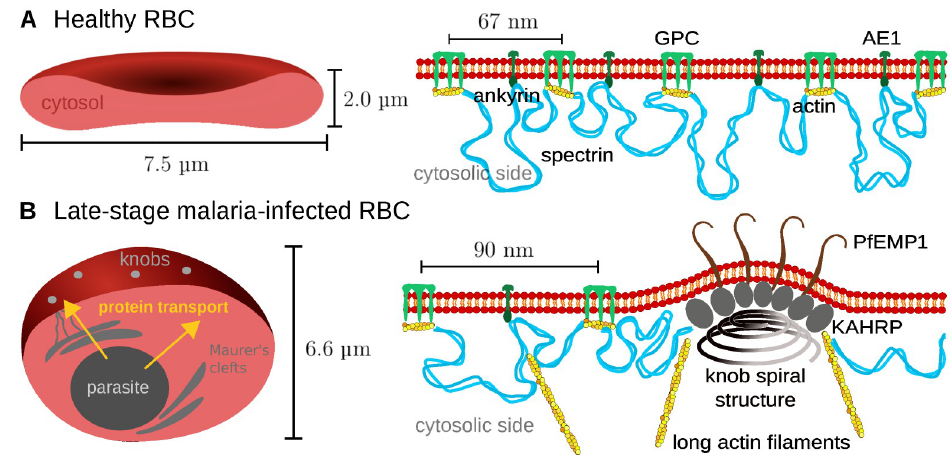
Fig 1. The membrane skeleton in healthy and infected red blood cells. (A) Left: schematic representation of a cut through a healthy RBC with a biconcave shape. Right: closeup of the coupling between the actin-spectrin network and the lipid bilayer. The actin protofilaments of the junctional complexes bind to glycophorin C (GPC) and ankyrin binds to anion exchanger 1 (AE1, also known as band 3). (B) Left: schematic representation of the late stage of the malaria infection, when the RBC has changed to a spherical shape and adhesive knobs have formed on its surface. Right: closeup of the internal structure of the knobs, with a spiral structure at the base, the PfEMP1 adhesion receptors in the membrane at the top and KAHRP-molecules inbetween. Actin is mined from the junctional complexes and forms long filaments often connected to the Maurer’s clefts.